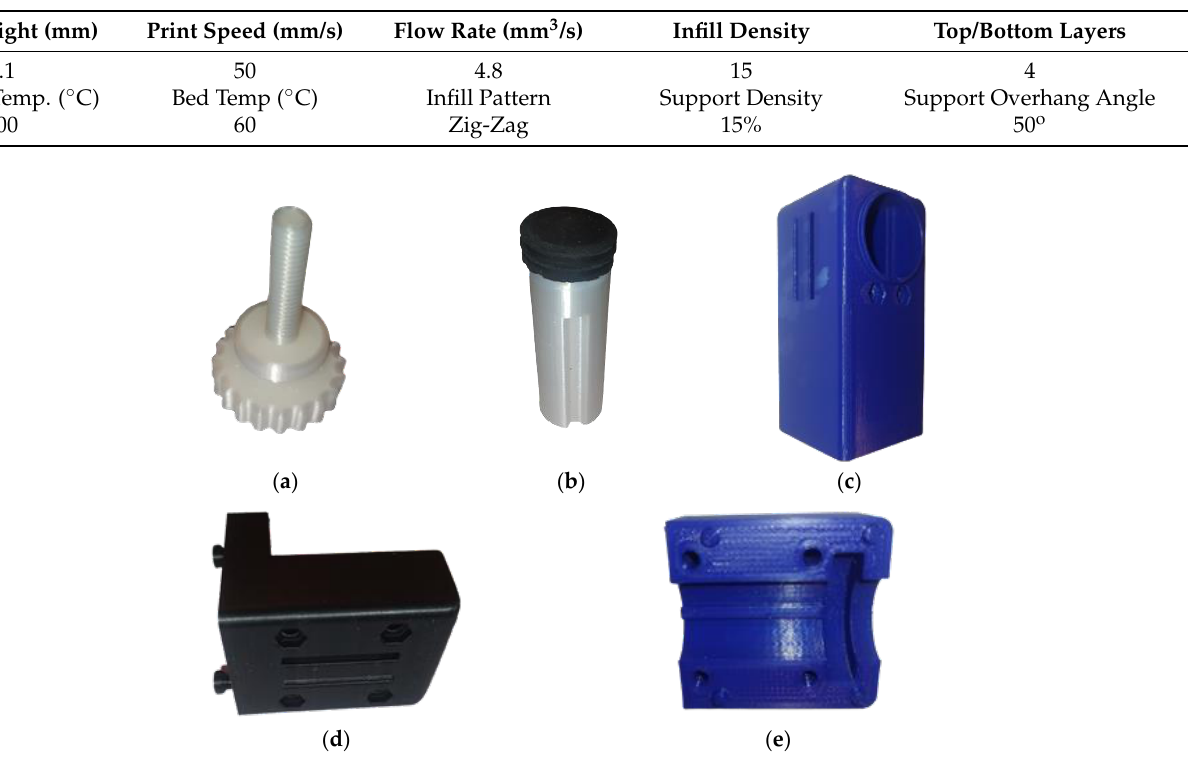
Figure 7. Print simulation in Cura of: ( a ) Rotating Lever; ( b ) Piston with seal; ( c ) Shell; ( d ) Shell Connection; ( e ) Shell Split. Table 1. 3D printing parameters using the FFF method for “Rotating Lever”.